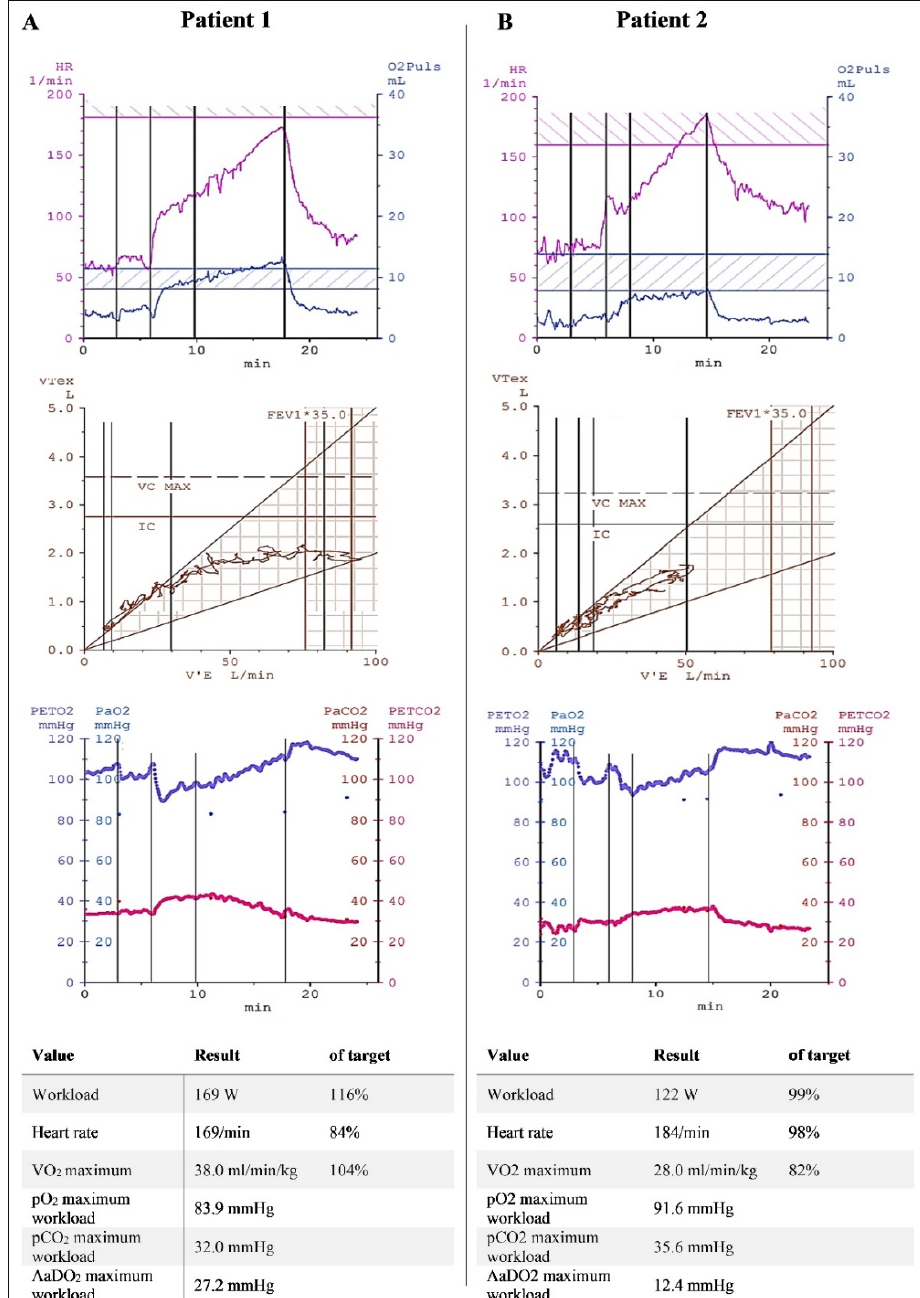
Figure 2. Cardiopulmonary exercise testing of a patient with no limitation ( A ) and a patient with deconditioning ( B ). The patient with no limitation showed a good and steady increase in heart rate and VO 2 pulse (top panel), with normal ventilatory volumes (middle panel) and expiratory gases (bottom panel). The workload and capillary blood gases were within normal ranges. The patient with deconditioning also showed a normal heart rate, normal ventilatory volumes, and normal blood gases, but significantly reduced VO 2 and a VO 2 pulse under the target corridor. (FEV1*35 is the product of one second capacity and 35 to estimate the maximum voluntary ventilation.)